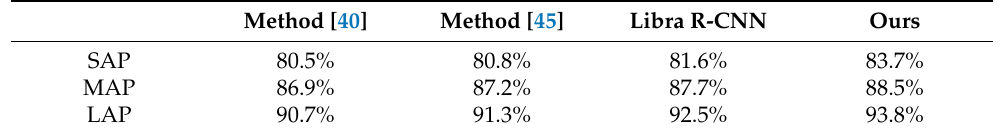
Table 4. Evaluation results of different